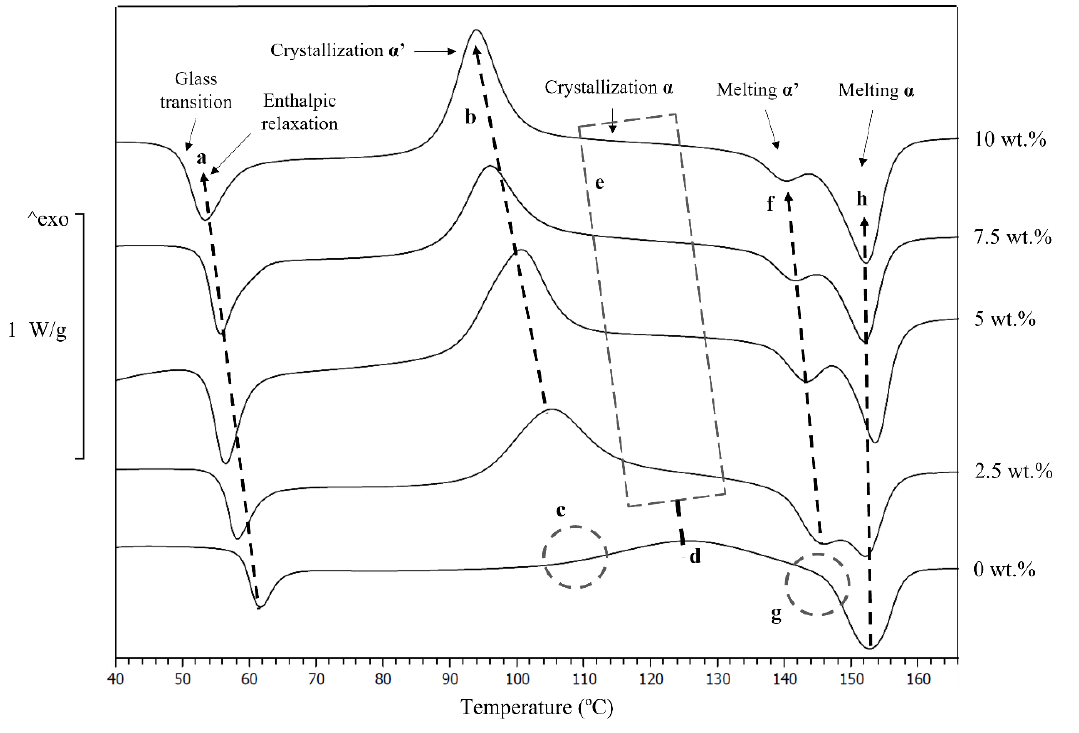
Figure 4. DSC at 10 °C/min of neat PLA and PLA-Mg with 2.5, 5, 7.5, and 10 Mg. (a) Evolution of glass transition and enthalpic relaxation toward lower temperatures, (b) appearance of first crystallisation, shifting towards lower temperatures with the increase in Mg content, (c) missing second crystallisation in neat PLA, (d) crystallisation on PLA without Mg, (e) uncertain shape of crystallisation on PLA-Mg composites, (f) first melting appeared in samples with Mg, (g) missing a melting peak in neat PLA, (h) melting point variation with Mg content. Table 1. Thermal properties of extruded 1D PLA and PLA-Mg filaments at a scanning rate of 10 °C/min. T g : glass transition; T ER : enthalpic relaxation temperature; ΔH ER : enthalpy of enthalpic re- laxation; T CC1 and T CC. 2 : cold crystallisation temperature of two crystalline phases, respectively; T m1 and T m. 2 : melting temperature of α′ and α crystals, respectively. Following the IUPAC convention, positive enthalpy changes indicate that the material absorbs the energy, which indicates an endo- thermal process. Melting and crystallisation enthalpies are not included in the table, as providing an accurate value was tricky due to the overlapping crystallinity values below 2% for all the sam- ples.